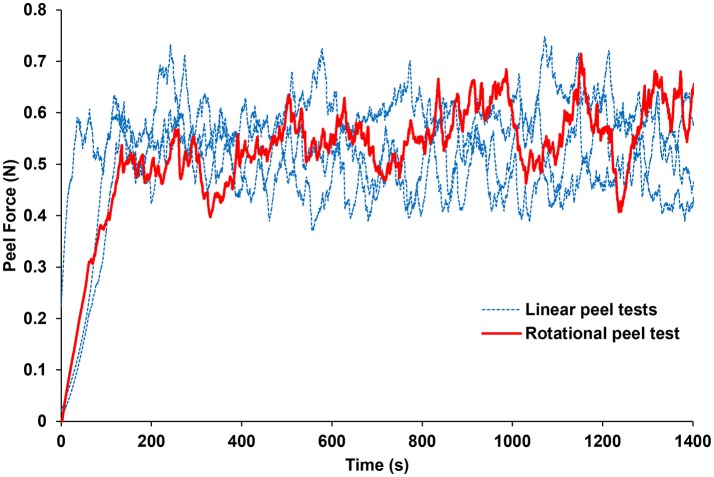
Average peel force measurements from the rotational tests were within 1.3% of the average peel forces measured from linear peel tests using ASTM standard D6862-11. Only one rotational peel test is plotted for clarity.